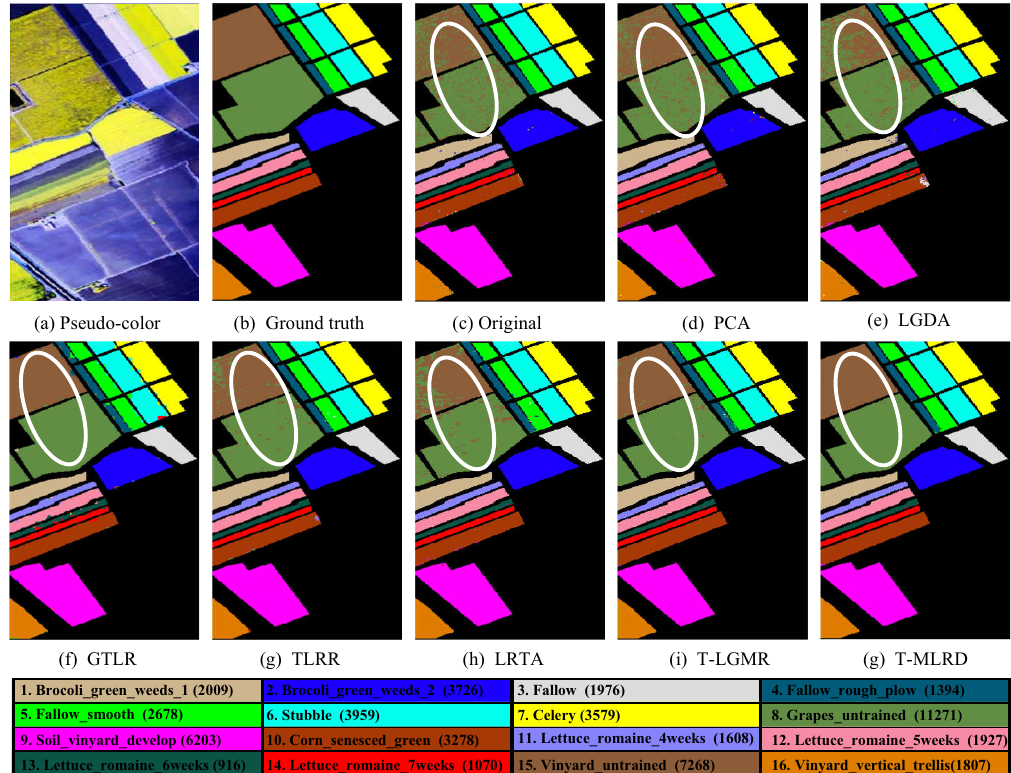
Figure 6. Classification maps of different methods on the Salinas